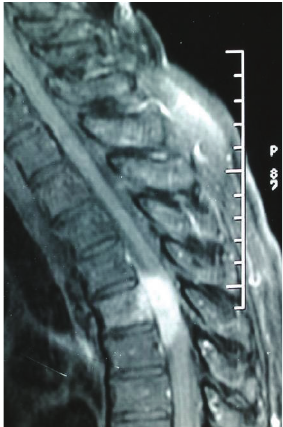
Figure 2: Preoperative sagittal T1-weighted postgadolinium MR image showing important tumor enhancement.